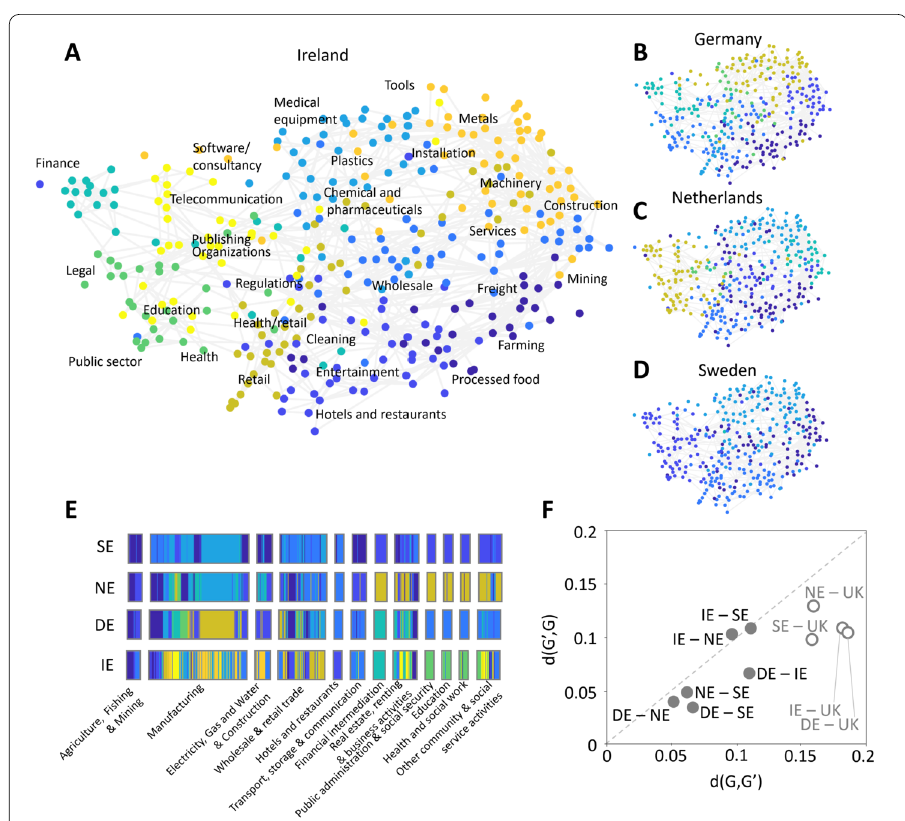
Figure 4 The pairwise comparison of the modular structure of five countries’ SRNs, namely: Ireland (IE), Germany (DE), the Netherlands (NE), the United Kingdom (UK) and Sweden (SE). In ( A ) we show the Irish SRN from O’Clery etal. [46]. The nodes represent industries and edges the skill-relatedness between the two corresponding industries. Nodes are coloured according to their community (found using the modularity optimization algorithm). The node layout is based on a spring algorithm called ‘Force Atlas’ in Gephi. Labelling is added to indicate the general position of sectors within the network. Using the same layout we also show communities detected for Germany, the Netherlands and Sweden in subfigure ( B ) to ( D ). In ( E ) we highlight the overlap of the community structure of each country with the official industrial sector classification. Industries are ordered and grouped by their 1-digit NACE 1.1 sector along the x -axis. For each country, industries are coloured according to community membership. In ( F ) we show the resulting BiDir